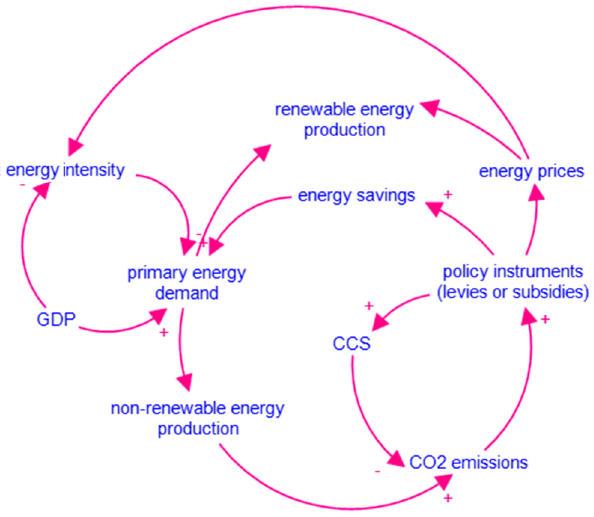
Figure 2. Causal Loop Diagram of System Dynamics Model for Energy Policy (SDMEP ).